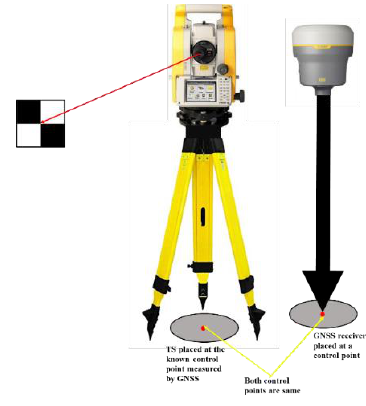
Figure 5. The surveyed point’s (i.e. checkerboard’s centre) coordinates measurement in UTM coordinate using TS and GNSS for the georeferencing of TLS point cloud.